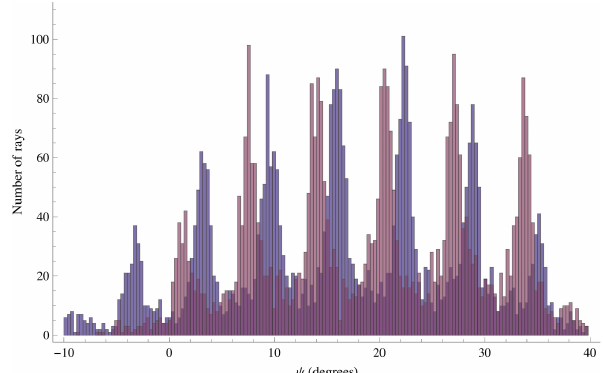
Fig. 6. Relative shift of two distributions of scattered rays from two different point sources at the shock